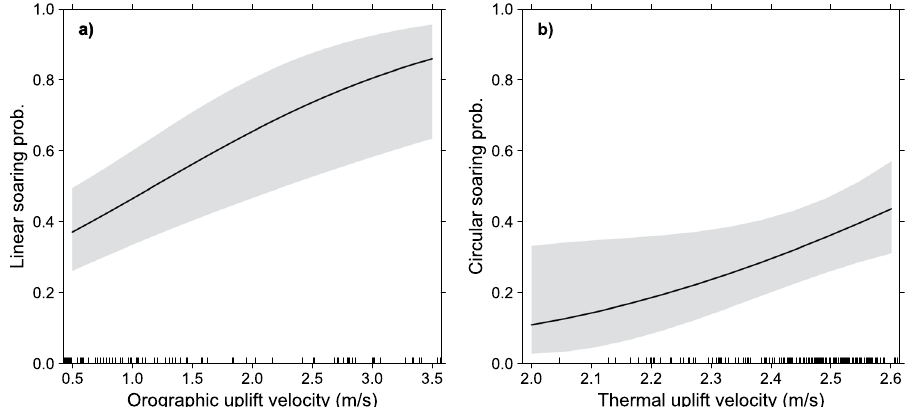
Figure 3. Model effects of orographic and thermal uplift on soaring modes of black kites. ( a ) Partial effect of orographic uplift velocity on linear soaring, and ( b ) partial effect of thermal uplift velocity on circular soaring. ( a ) and ( b ) resulted from two binomial GLMM models. In ( a ) the response variable was 1 if the track segment was classified as linear soaring and 0 if classified as gliding. Model fixed factors were orographic and thermal uplift velocities, and random factors were bird identifier and the day of data collection. In ( b ) the model was similar to ( a ) but dependent variable was 1 for circular soaring and 0 for gliding. Only factors with significant effect in the models are shown. Shading represents 95% confidence intervals.